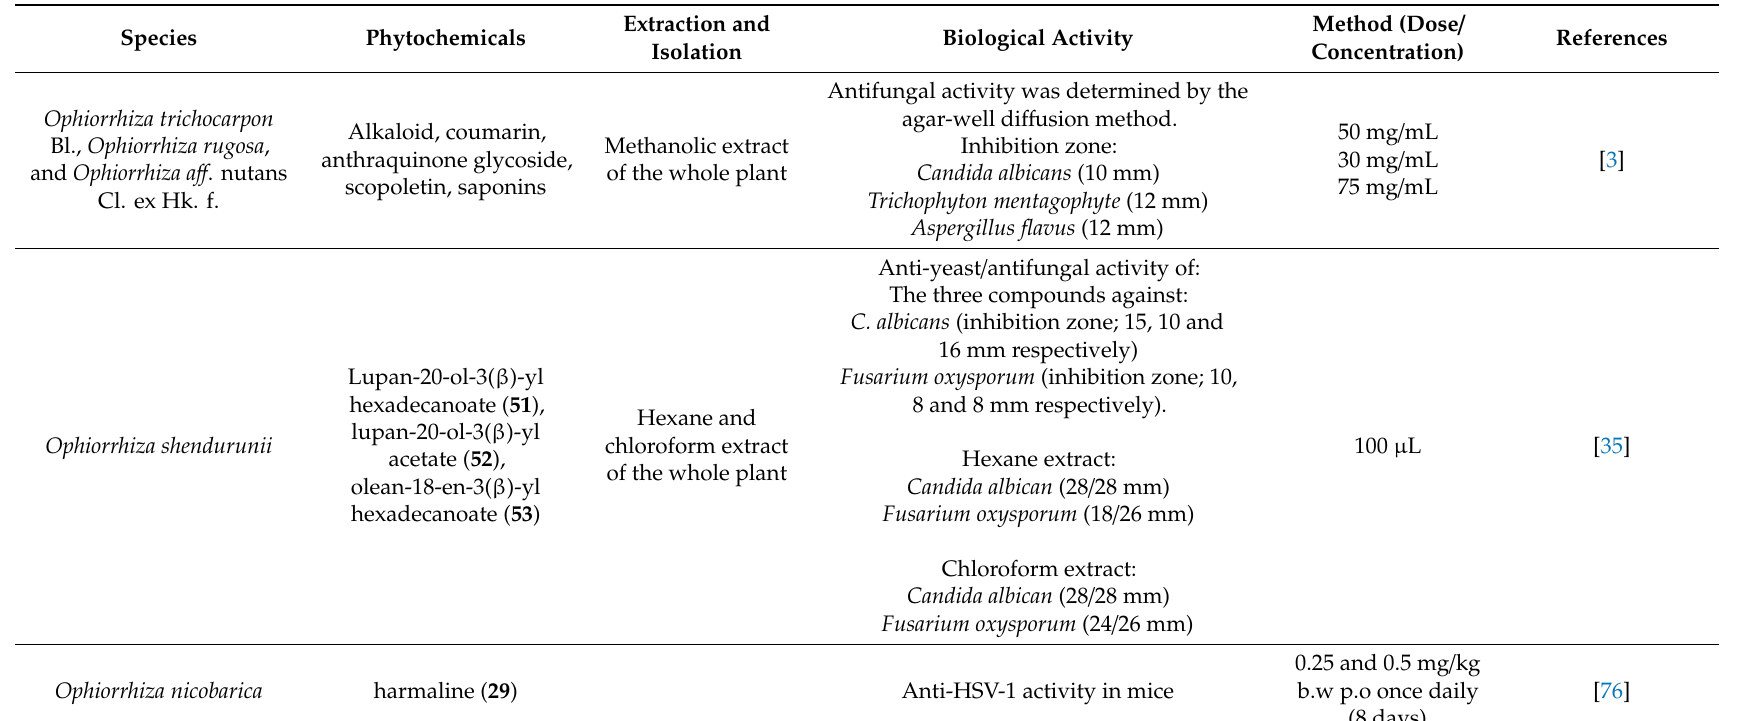
Table 7. Antiviral